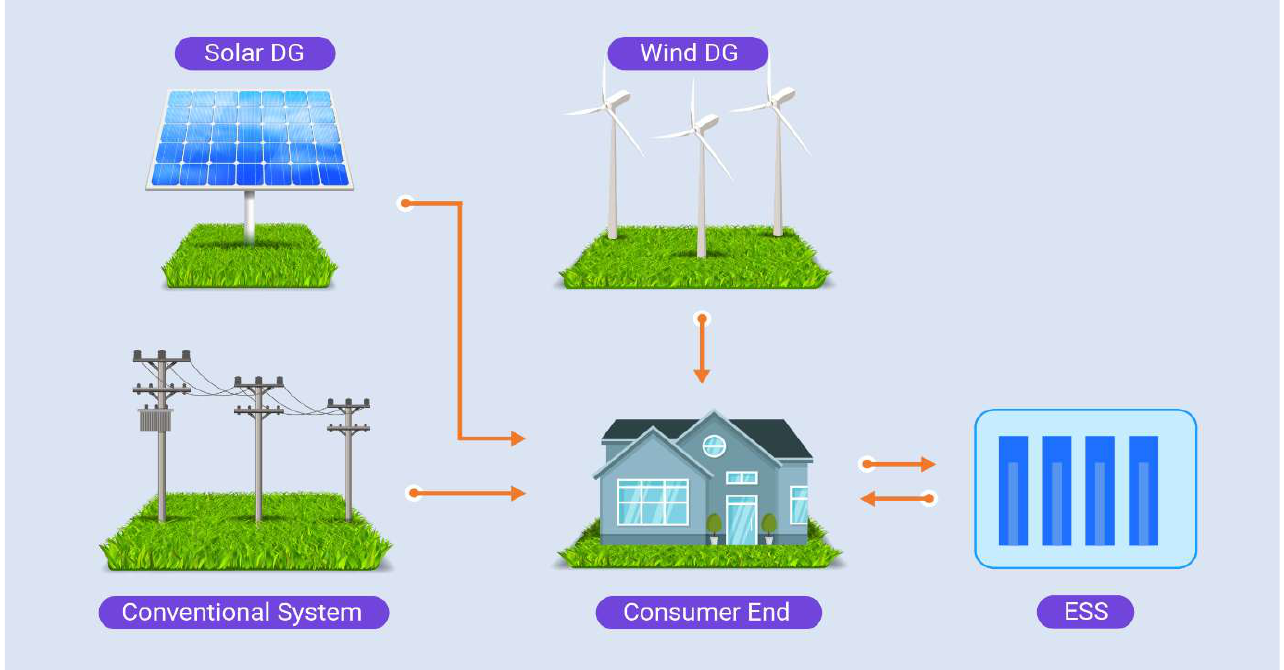
Figure 1. Scenario of domestic utility in PS.